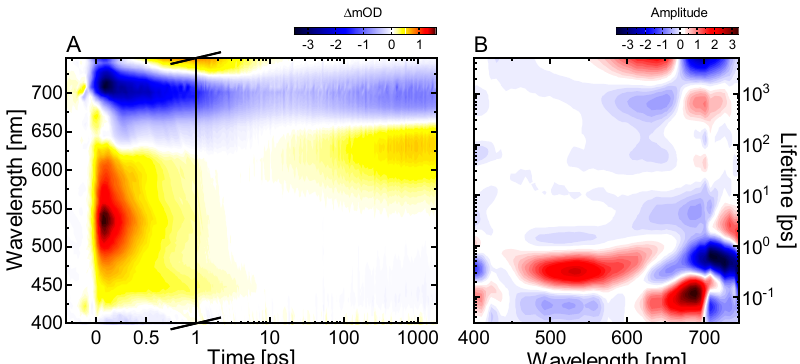
Figure 5. Ultrafast excited state dynamics of the P fr state in Syn Cph2 investigated in the UV/vis spectral range. ( A ) TA data of the P fr → P r dynamics after excitation at 710 nm. ( B ) Corresponding lifetime density map (LDM) obtained from the lifetime distribution analysis of the TA data displayed in A).